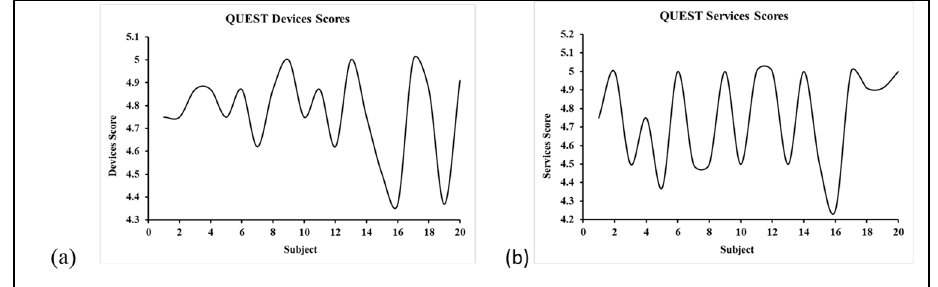
Figure 12. QUEST (a) devices and (b) services scores . Figure 12. QUEST ( a ) devices and ( b ) services